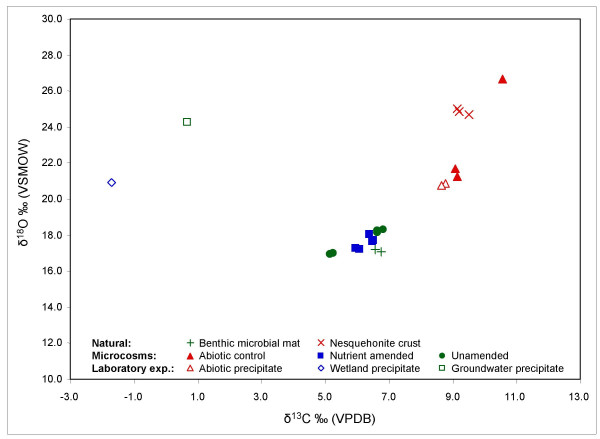
Isotope compositions (δ18O vs. δ13C) of natural samples of benthic microbial mat and nesquehonite crusts, as well as precipitates from the field microcosm and laboratory precipitation experiments.